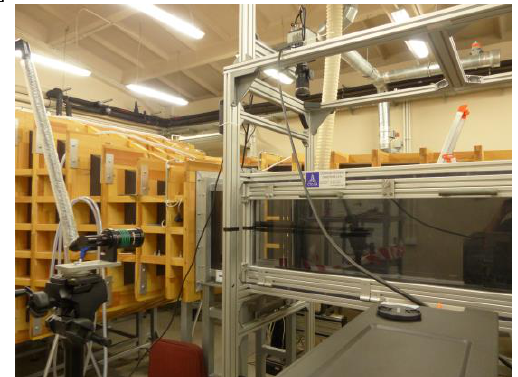
Fig. 1. Experimental